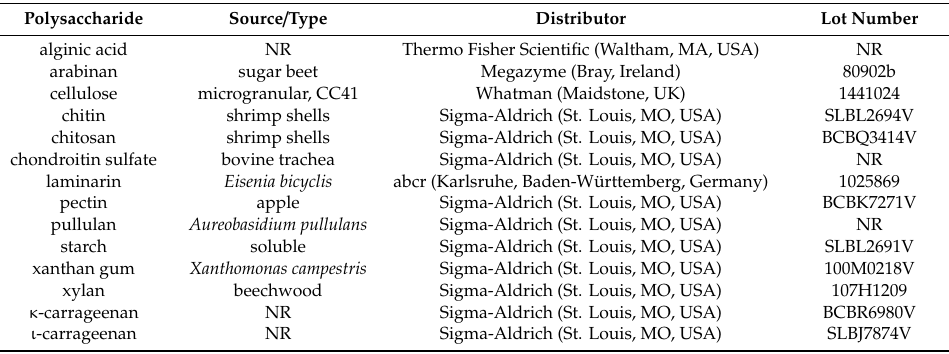
Table 1. Polysaccharide substrates used in this study, their source or type, distributor and lot number, if mentioned on the packaging. “NR” stands for “not